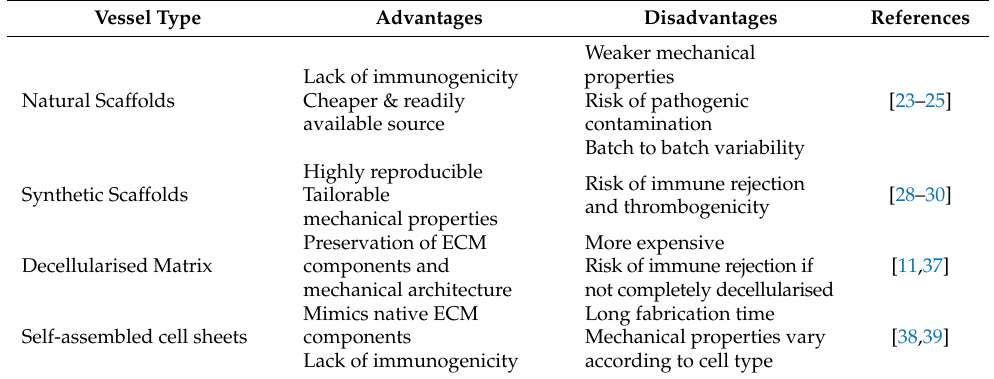
Table 1. Advantages and disadvantages of different scaffold techniques in the production of TEVGs. Vessel Type Advantages